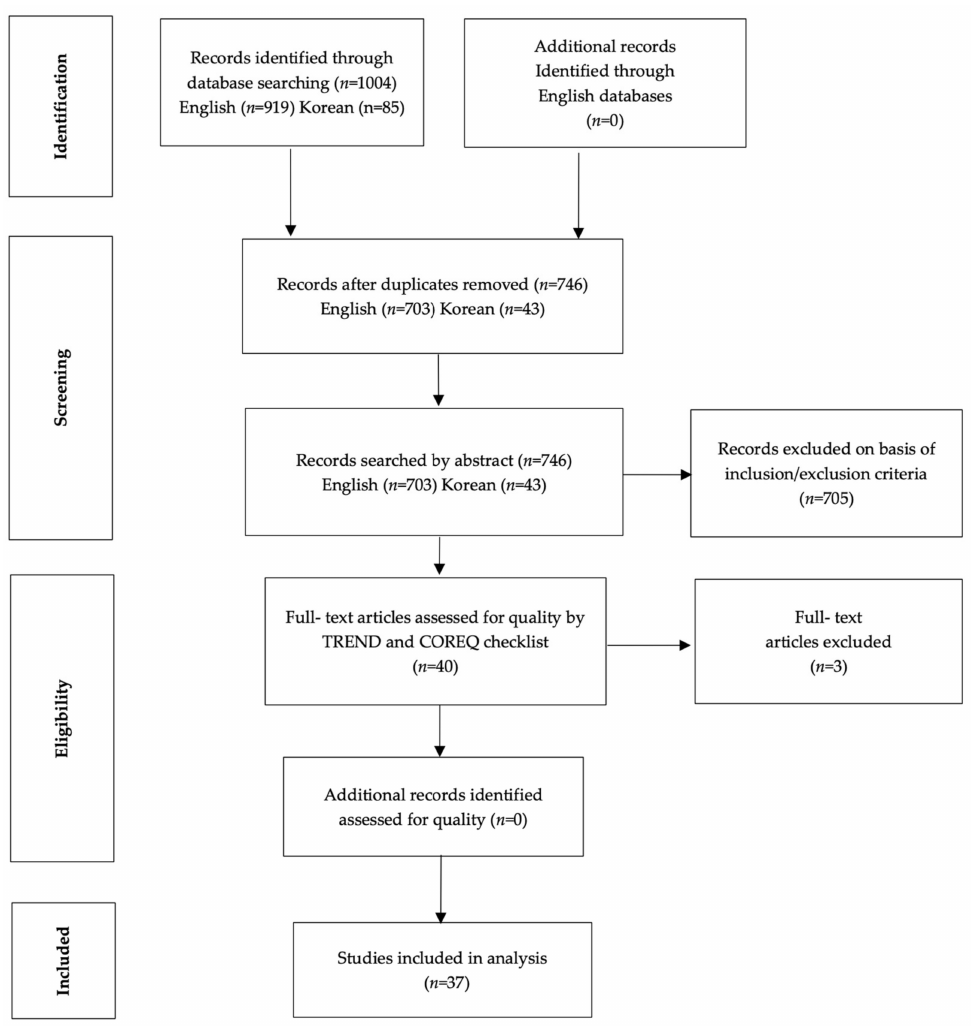
Figure 1. Flow diagram from literature